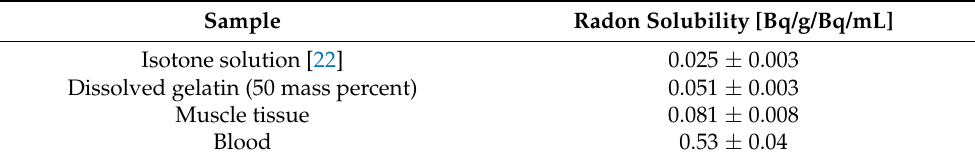
Table 5. Radon solubility in samples with a high proportion of water (>75%).